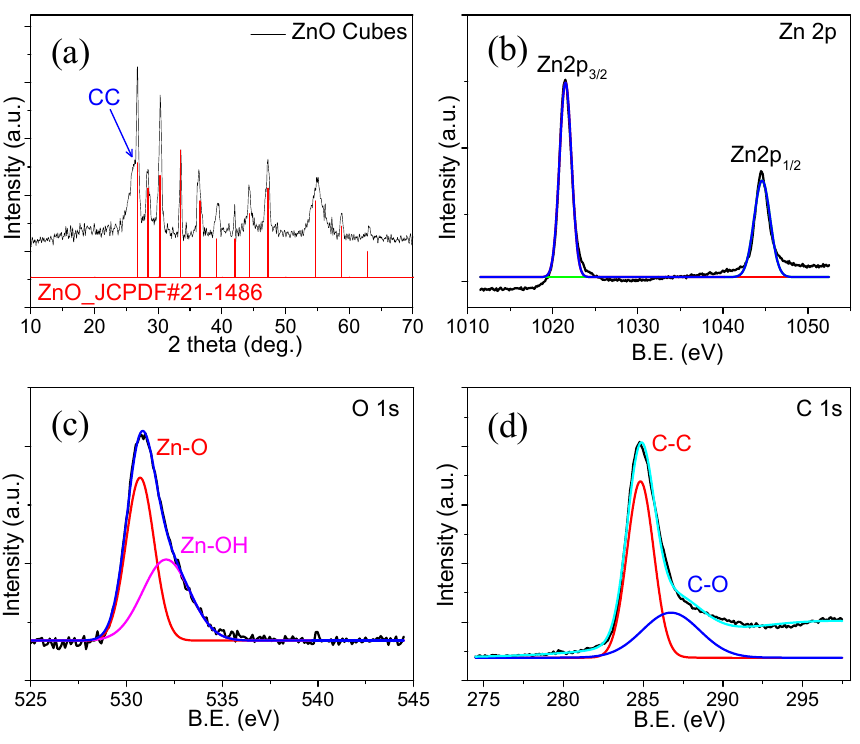
Figure 3. ( a ) XRD pattern, ( b ) Zn 2p, ( c ) O 1 s, and ( d ) C 1 s spectrums of ZnO@CC.